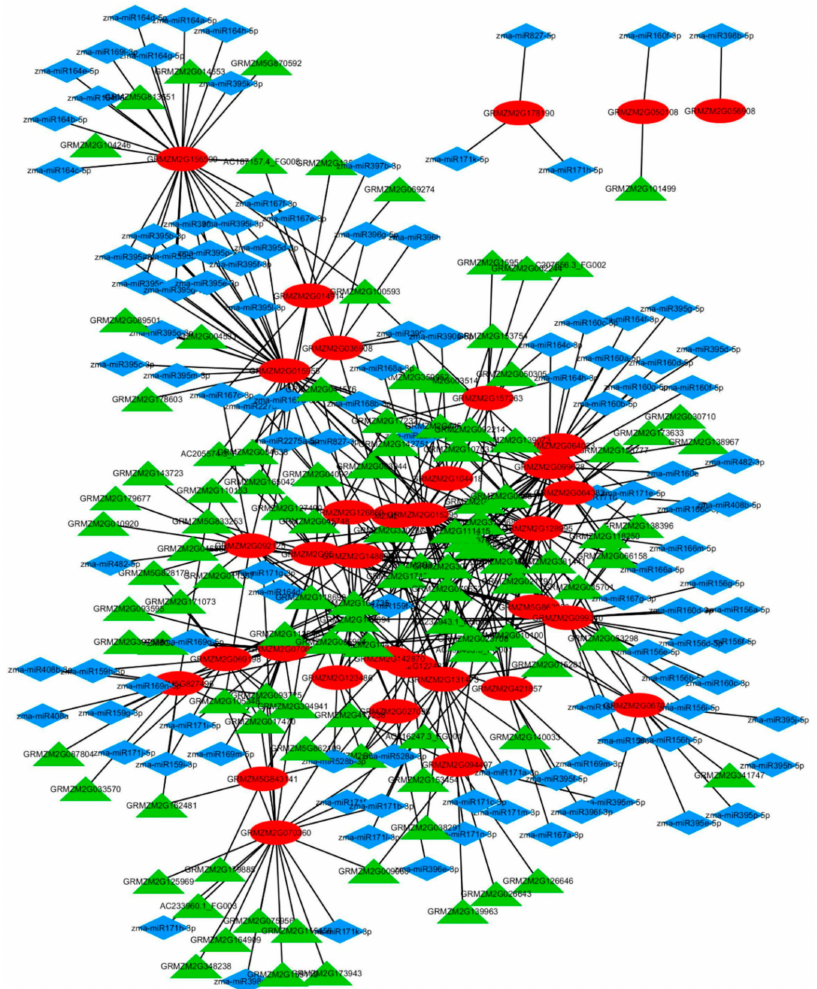
Figure 7. The transcription factors (TFs) and miRNAs mediated the regulation of di ff erentially expressed transporters under Fe and Zn deficiency in maize: the regulatory network is characterized by 148 miRNA–target gene and 306 TF–target genes interactions. The green triangles represent the TFs, the red ovals represent the target transporters and mugineic acid pathway genes, and the blue diamonds represent